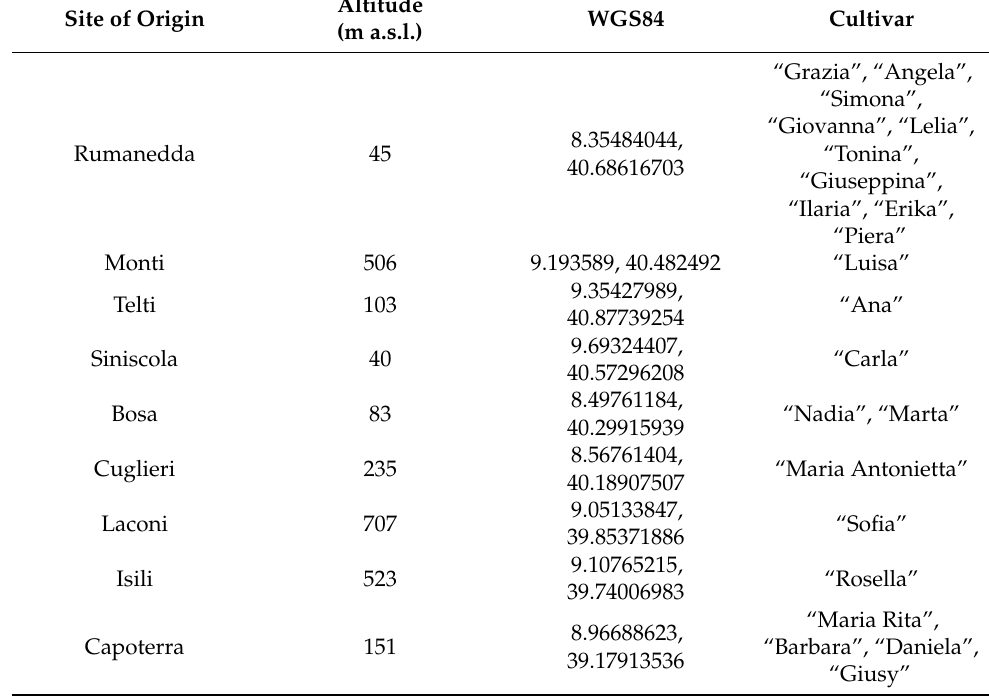
Table 1. Analysed cultivars and its sites of origin in Sardinia as reported in the Figure 1. The altitudes and coordinate of the in sites of origin are